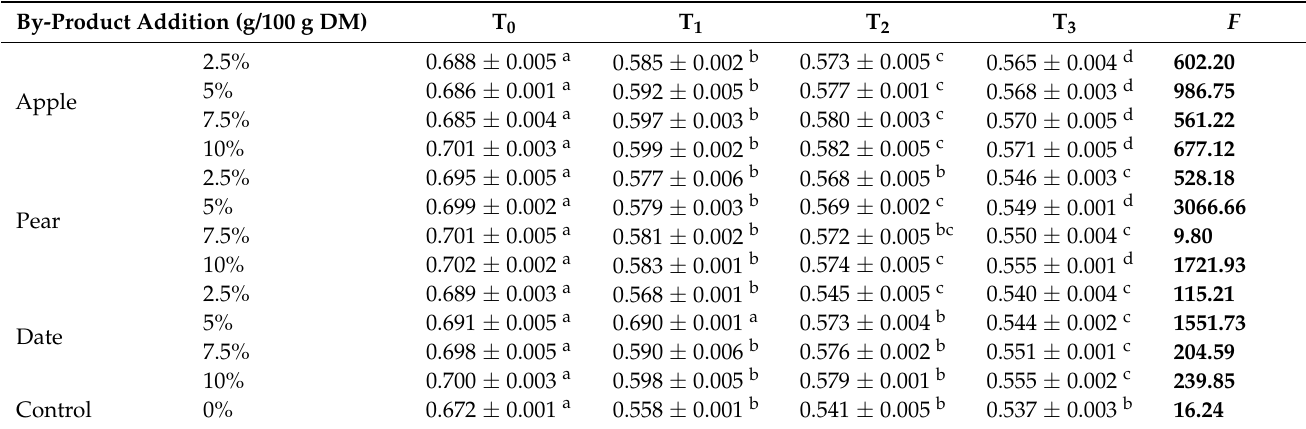
Table 5. Water activity of by-product-enriched pasta formulations during